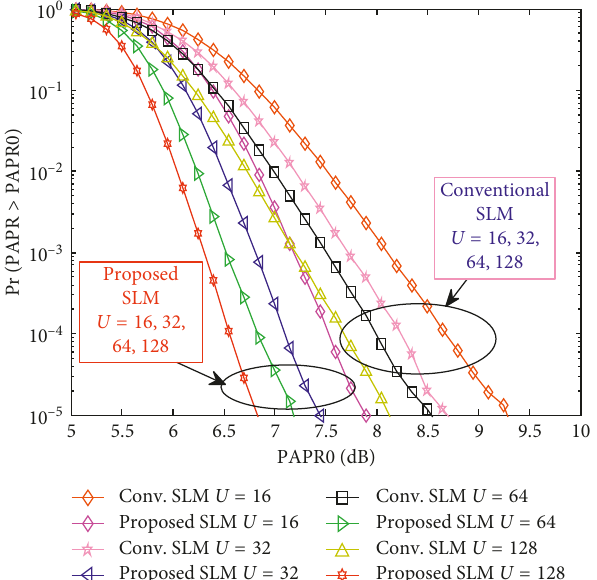
Figure 3: Comparison of SLM given in [5] with the proposed SLM for U � 16, 32, 64, and 128, N � 128, and 4-PSK.